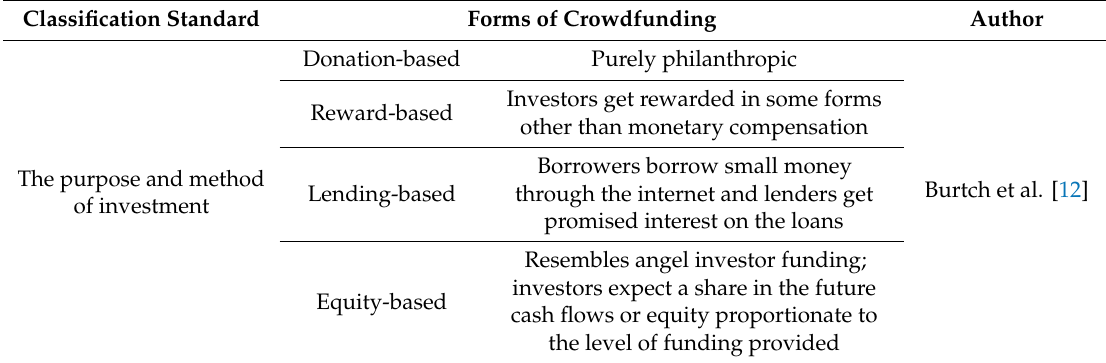
Table 1. Forms of crowdfunding based on the purpose and